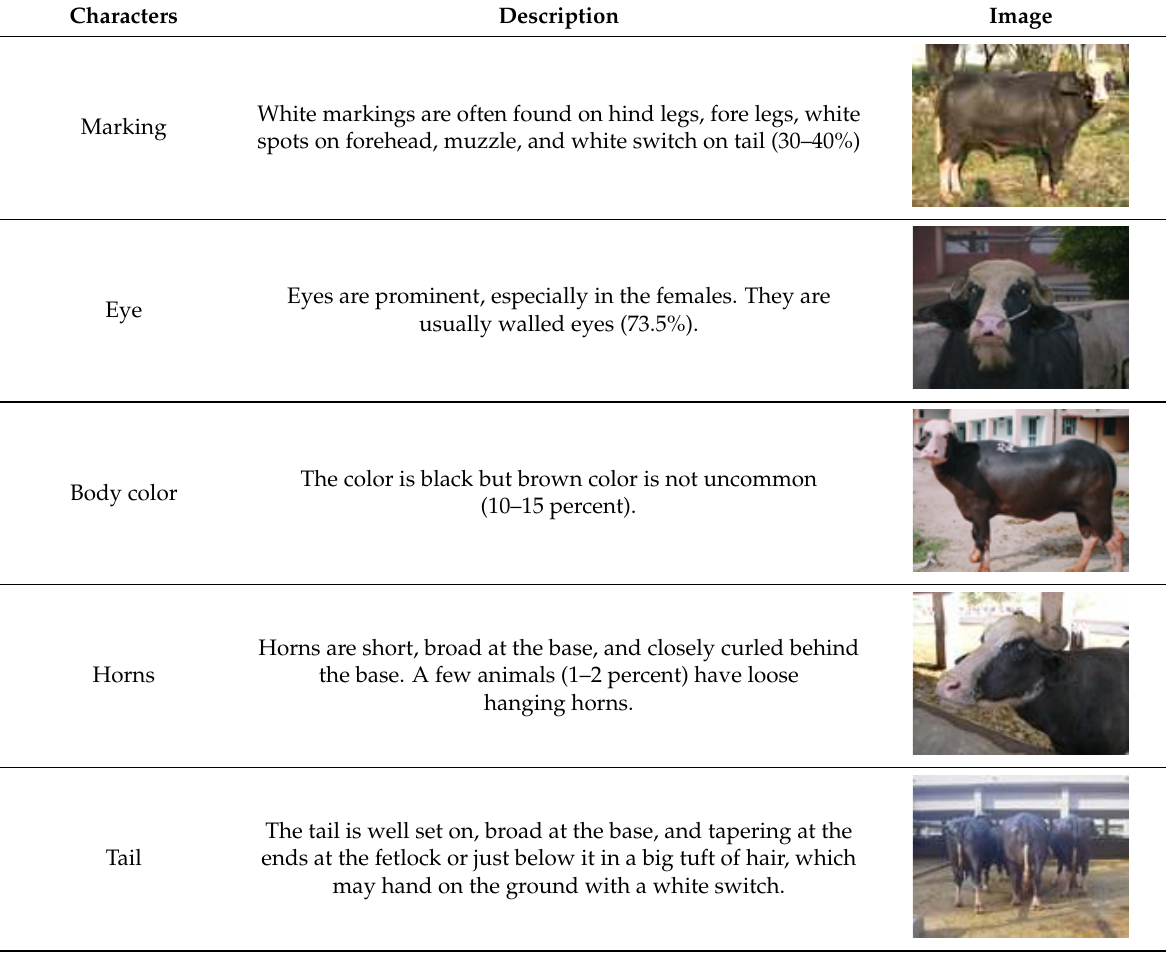
Table 1. Morphological features of Nili-Ravi